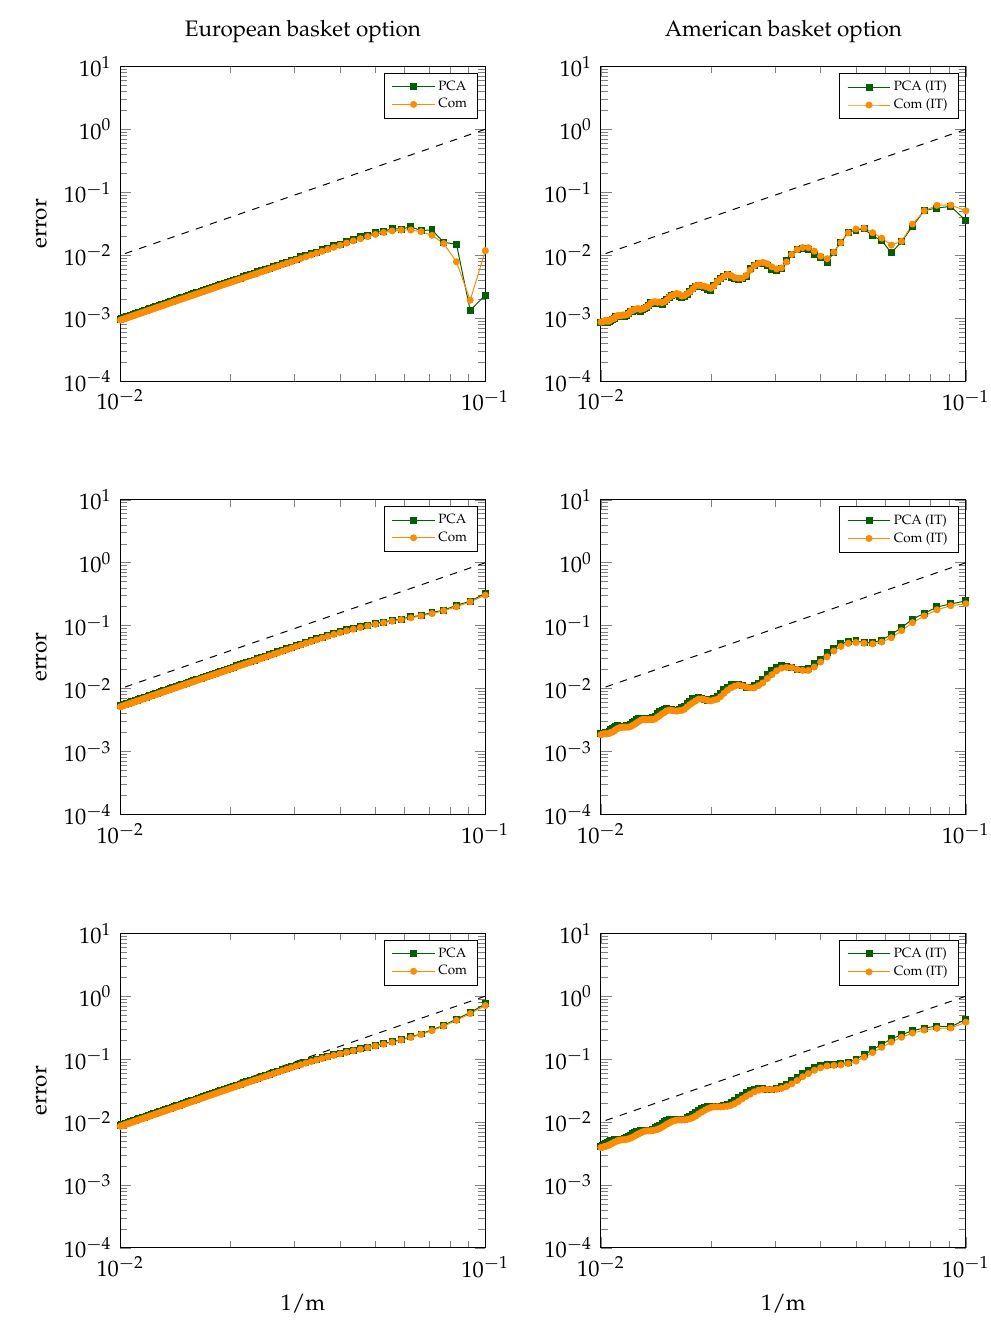
Figure 3. Discretisation error for r u p S 0 , T q and u app p S 0 , T q in cases D ( top ), E ( middle ) and F ( bottom ). Left : European basket option. Right : American basket option. Reference line (dashed) included for second-order